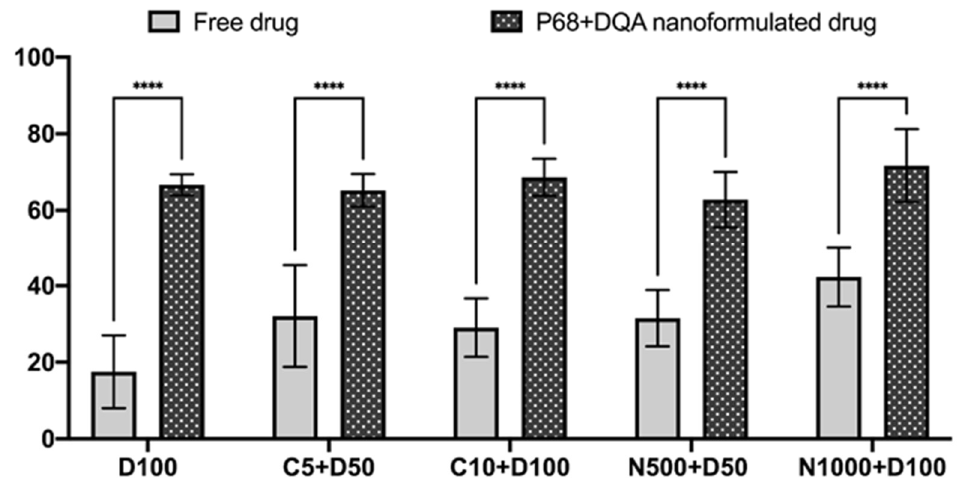
Figure 5. Mean percentage of DFO in the basolateral compartment of the hCMEC/D3 Transwell ® system following 60 min treatment with free or P68 + DQA DFO (100 μ M), combined curcumin and DFO (5 and 10 μ M curcumin + 50 and 100 μ M DFO, respectively) and combined NAC and DFO (500 and 1000 μ M NAC + 50 and 100 μ M DFO, respectively). Per-centage DFO = ((absorbance of the basolateral compartment sample − control)/(absorbance of the treatment − control)) × 100, where the absorbance was read at 204 nm and the control was MEM. * represents significance values of nanoformulated drug compared to free drug within the same treatment condition (**** p < 0.0001).